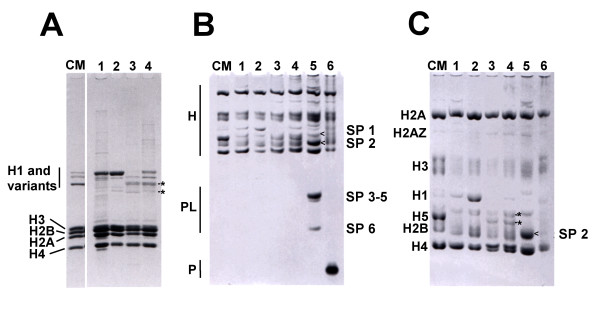
Electrophoretic characterization of R. catesbeiana, X. laevis and B. marinus SNPBs. Characterization of histones and SNBPs extracted from different tissues by: A) SDS-PAGE; B) AUT-PAGE run for a short time duration to separate histones (H), protamine-like proteins (PL) and protamines (P); and C) AUT-PAGE run for a longer duration to separate histones. Lane 1: R. catesbeiana liver; lane 2: R. catesbeiana blood; lane 3: R. catesbeiana sperm; lane 4: R. catesbeiana testes; lane 5: X. laevis testes; lane 6: B. marinus testes. CM; Chicken erythrocyte histones used as a histone marker. The SNBPs of X. laevis in lane 5, called sperm-specific proteins (SP1-6), are labeled and arrows (<) are used when needed to clearly indicate which bands the labels refer to. The asterisks point to the sperm-specific histone H1 complement in R. catesbeiana.